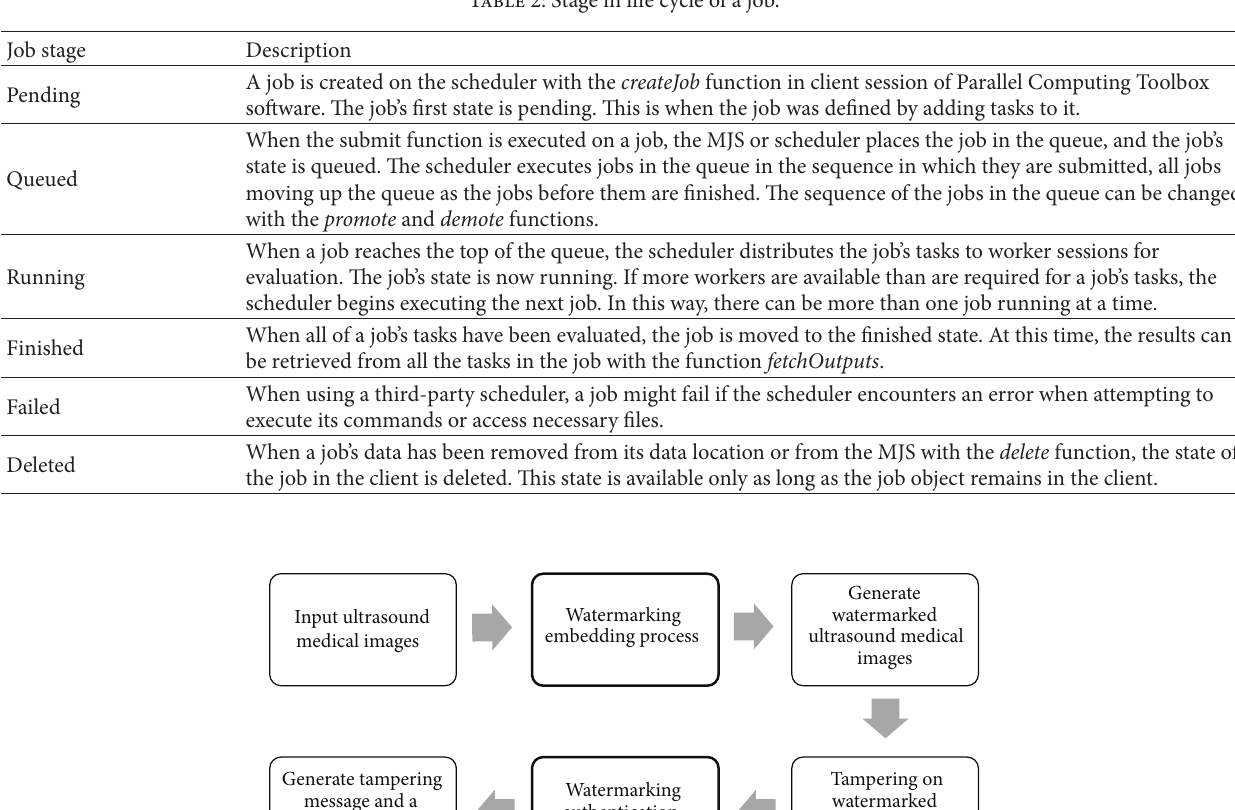
Table 2: Stage in life cycle of a job.